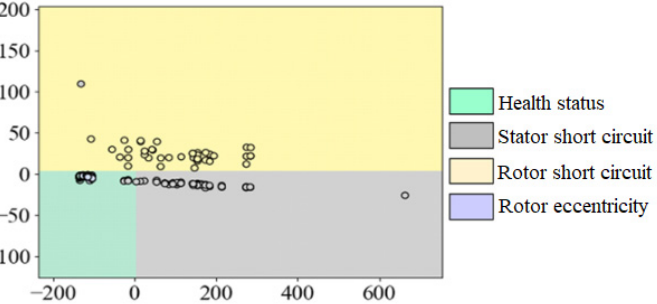
Figure 6. Classification result without the fuzzy process after removing the change period of the unbalanced force direction.